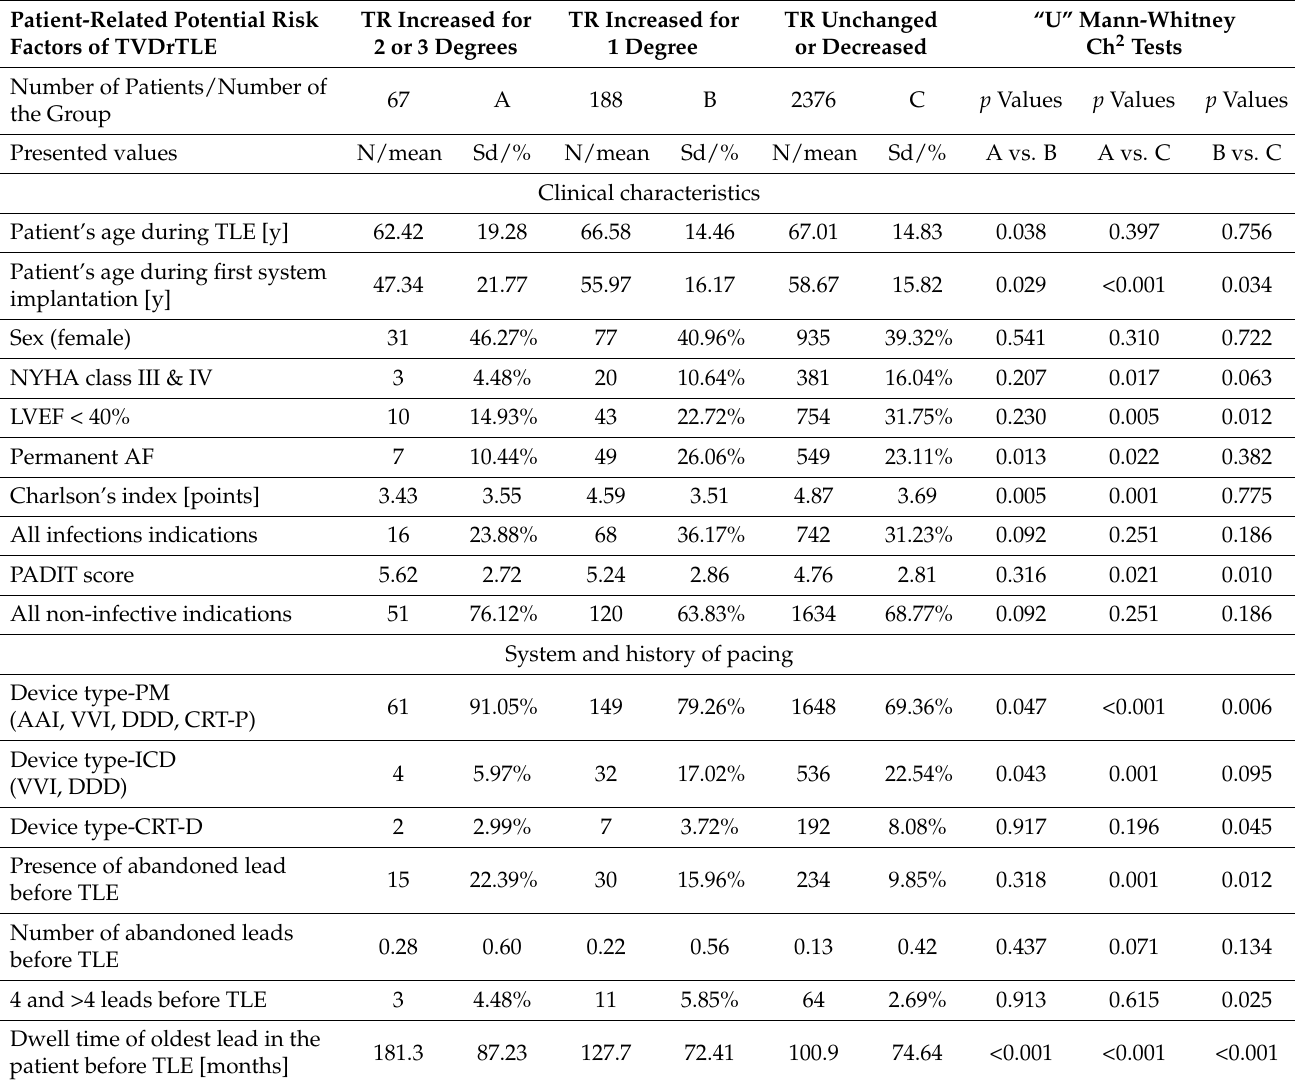
Table 2. The comparison of patient-related, indication-related, system-related and history of pacing- related potential factors of TLE-related